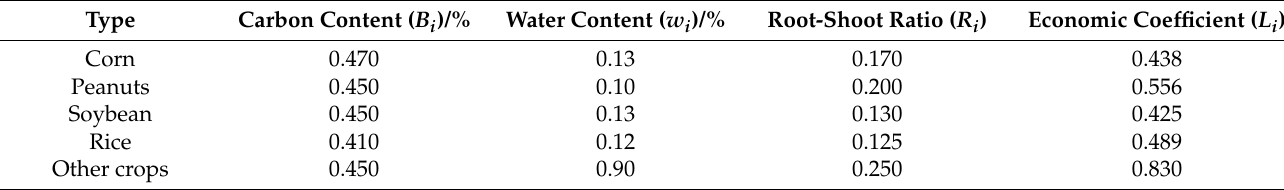
Table 2. Estimation parameters of crop carbon sequestration.